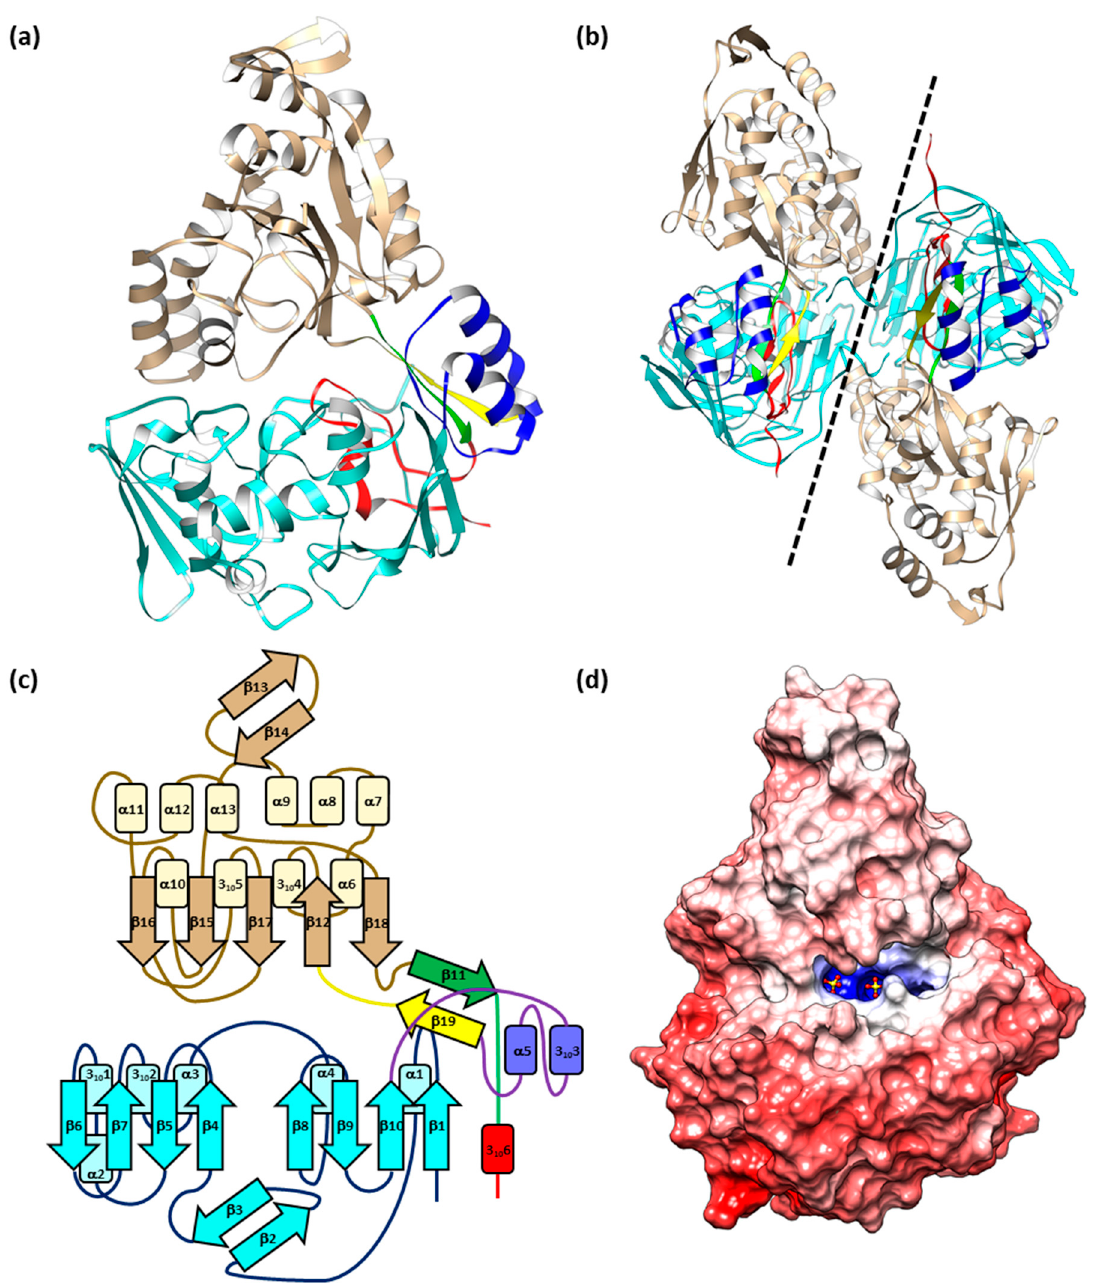
Figure 1. ( a ) Schematic representation of EppA’s structure. Arrow and rectangles are helices and β -strands, respectively. Domain I is aquamarine, Domain IIa is blue, Domain IIb is red, and Domain III is tan. The yellow and green strands, which belong to Domain IIa and IIb, respectively, form the hinge. ( b ) Structure of EppA in the P2 1 2 1 2 space group. The dashed line shows the intermolecular interface between the two monomers, which are related by non-crystallographic 2-fold symmetry. ( c ) Topology diagram of EppA. ( d ) EppA’s electrostatic potential surface on a scale of − 12.5 kT/e (red) to +12.5 kT/e (blue), with white at 0 kT/e. The two sulfates in the ligand-binding site are shown as red (oxygen) and yellow (sulfur) ball-and-stick models.